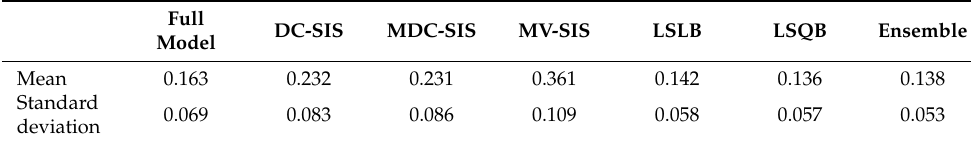
Table 2. Test errors of RF in the real data